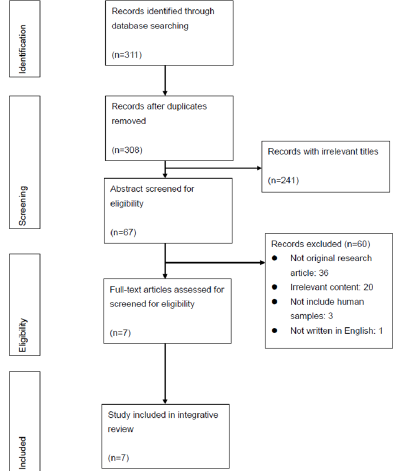
Figure 1. PRISMA Diagram of Search Results and Screening Process.